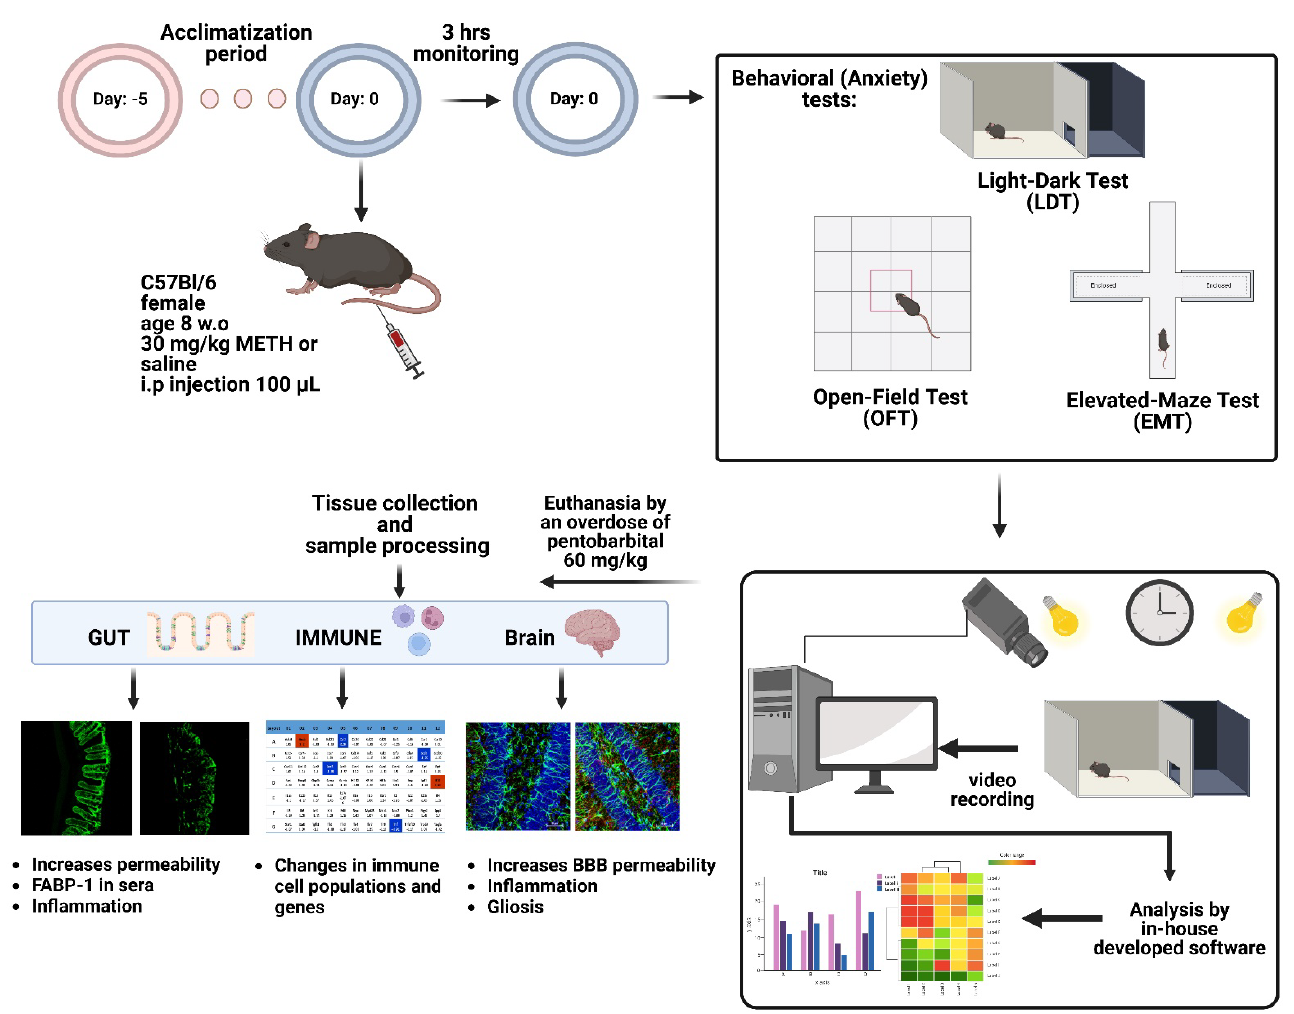
Figure 1. Schematic summary of the experimental design and outcomes in the gut, brain, spleen and sera of mice following an acute dose of METH.